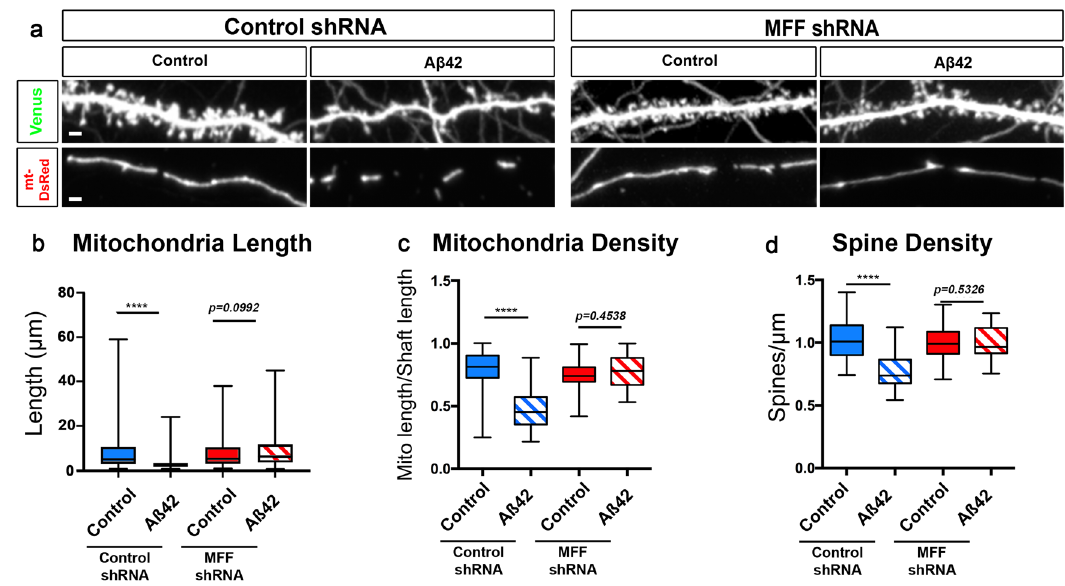
Fig. 5 | MFF is required for A β 42o-induced dendritic mitochondrial fragmen- tation and dendritic spine loss in vitro. a Representative images of secondary dendriticsegmentsofprimarycorticalPNsat21DIV.EmbryosatE15.5wereexutero electroporated with pCAG-mVenus, pCAG-mito-DsRed, and either with control shRNA or anshRNA speci fi c for mouse MFF (MFFshRNA). Neurons weretreated at 20 DIV with either a vehicle control or A β 42o for 24h. Knockdown of MFF blocks bothdendriticmitochondrialfragmentationandsubsequentdegradationaswellas dendritic spine loss. b – d Quanti fi cation of dendritic mitochondrial length ( b ), dendritic mitochondrial density ( c ), and dendritic spine density ( d ). All of the analysesweredoneblindtotheexperimentalconditionsandweredonebymanual